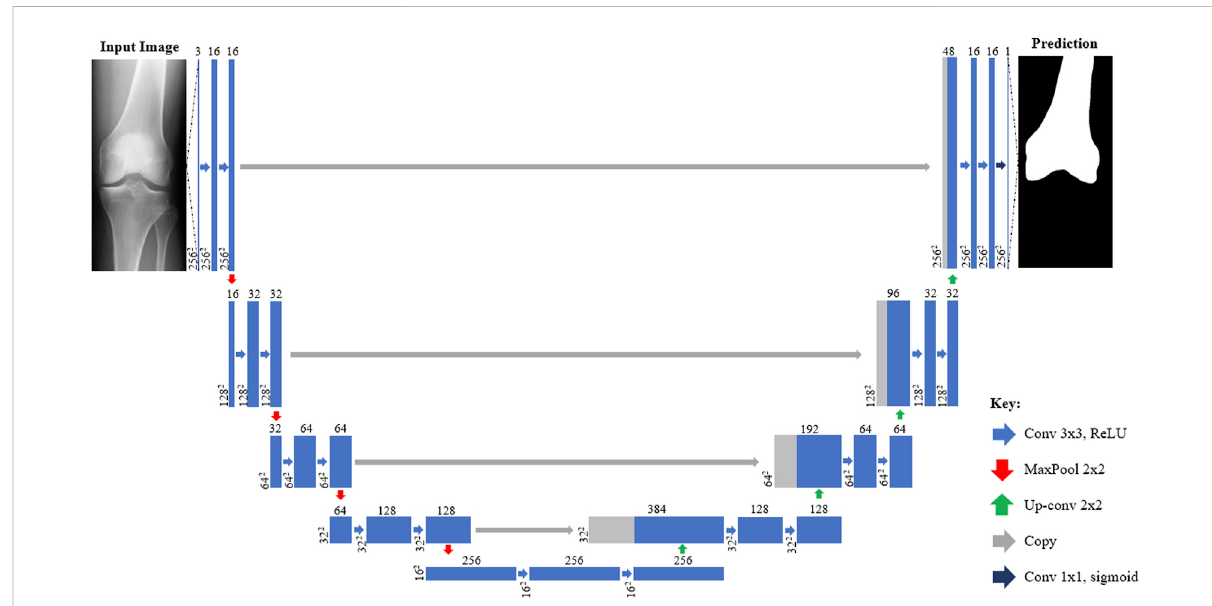
FIGURE 2 Architecture of U-Net CNN X-ray segmentation models from inputted X-ray image (left) to predicted mask (right). Each box corresponds to a multi-channel feature map with those shaded grey indicating where channels have been copied from previous layers. The number of channels is denoted on top of each box with the size provided at the lower left (256 2 = 256 × 256 pixels). Arrows denote different operations such as